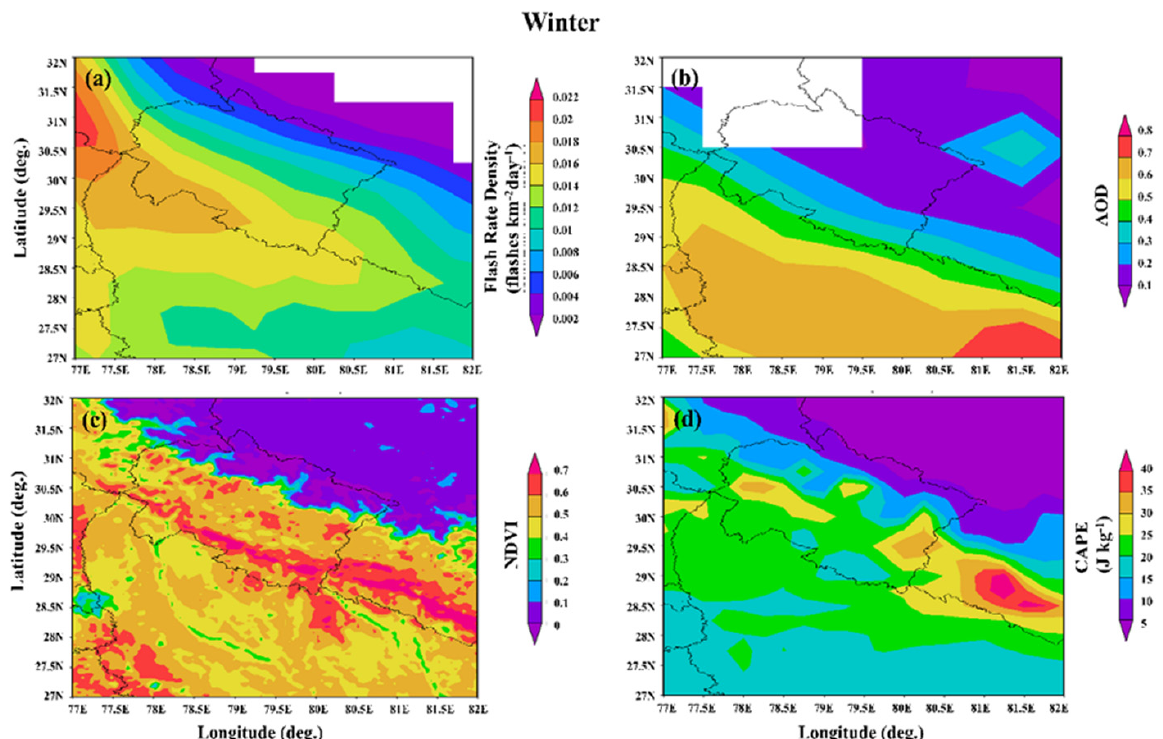
Figure 3. Spatial distribution of ( a ) LFRD, ( b ) AOD, ( c ) NDVI, and ( d ) CAPE for the winter season over the study region.